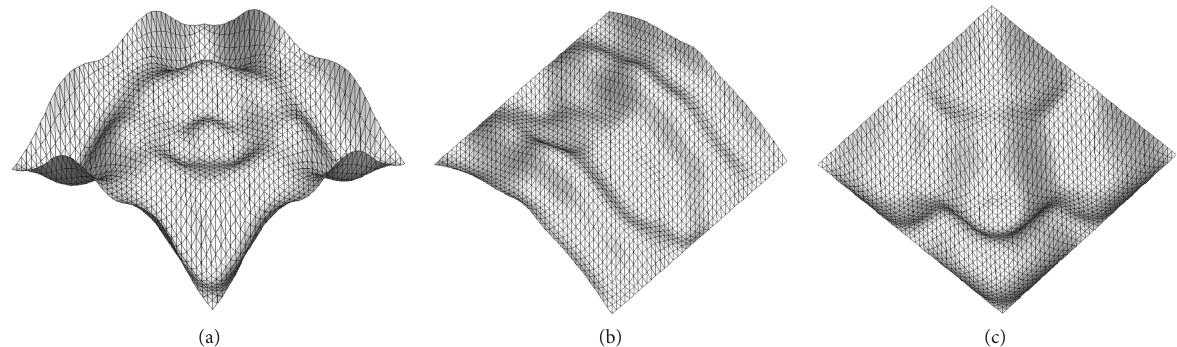
Figure 16: Optimal shapes and stacking sequences with increased number of variable control points (Approach 1). (a) Shell 1 [ − 45 ° /90 ° /0 ° / 90 ° /0 ° /45 ° / − 45 ° /45 ° ] s . (b) Shell 2 [0 ° /90 ° /45 ° /0 ° / − 45 ° 2 /90 ° / − 45 ° ] s . (c) Shell 3 [45 ° /0 ° / − 45 ° /90 ° /0 ° /90 ° / − 45 ° /45 ° ] s .